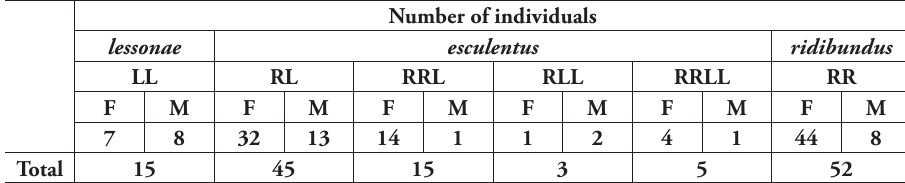
Table 2. Number, sex, taxonomic status and genotype of juvenile progeny of artificial crosses. Number of individuals lessonae esculentus